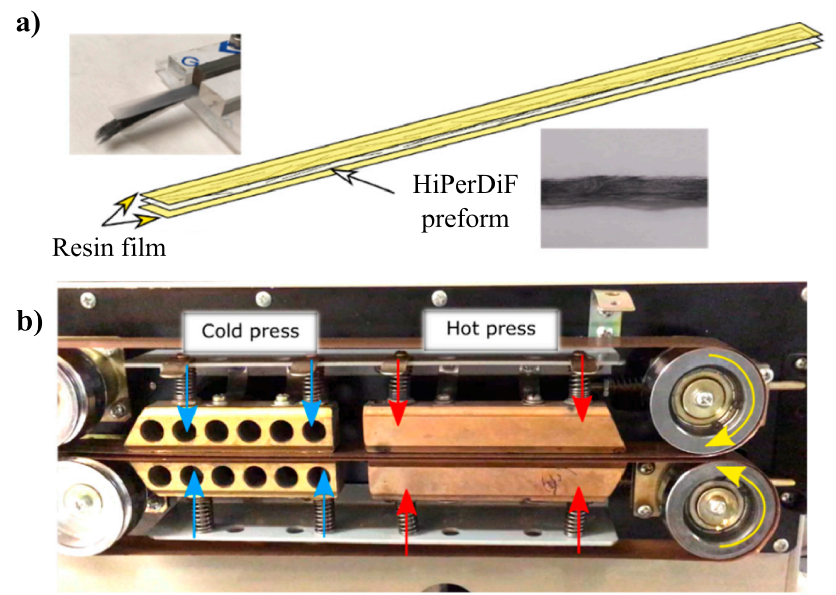
Figure 2. ( a ) An example of the HiPerDiF (carbon fibre) preform sandwiched between two polymeric films before consolidation process ( b ) Prepregging process. Figures were taken from